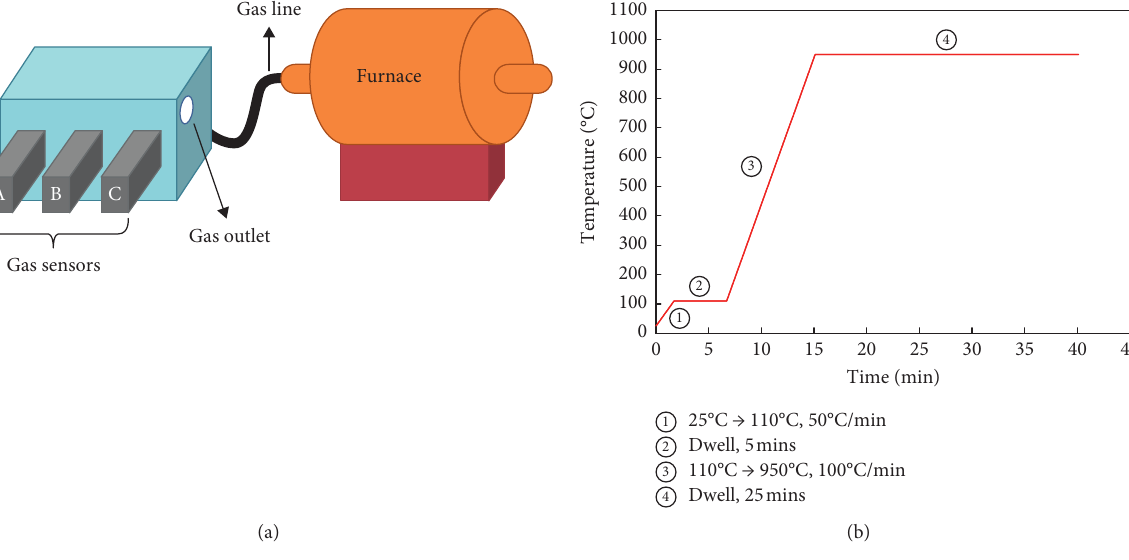
Figure 2: (a) Diagram of combustion gas analysis where gases were fed to a chamber fed into 3 different detectors placed to detect different gas. (b) Temperature versus time plot of thermogravimetric analysis profile of the sample from 25 ° C to 950 °